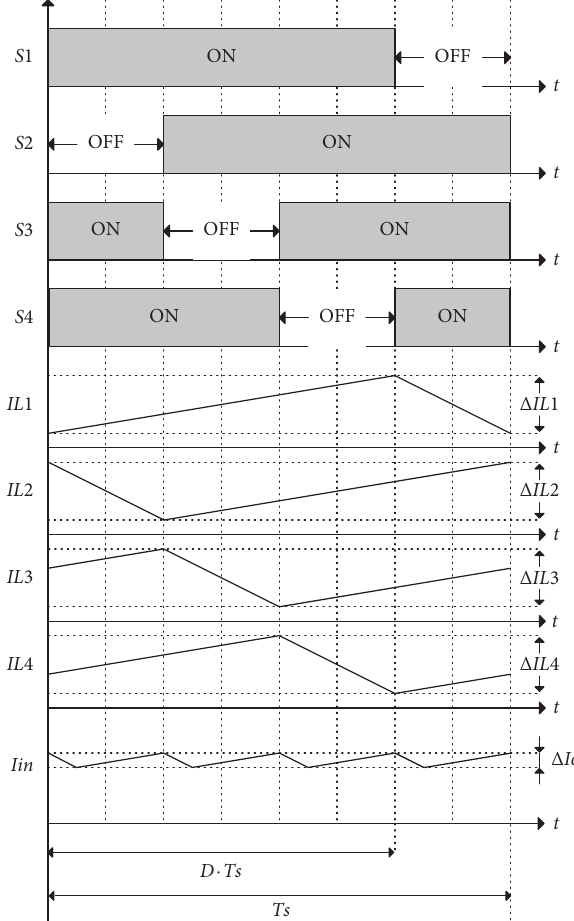
Figure 6: Switching pattern and inductor current waveform in range of duty ratio as 3/4.